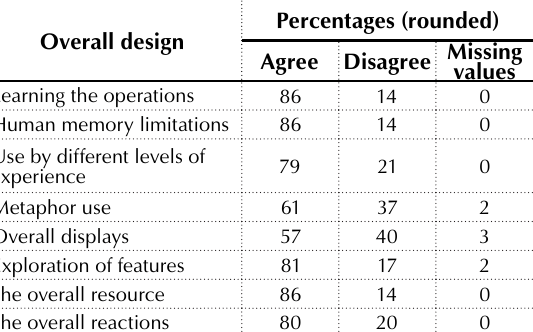
Table 4. Users’ responses to